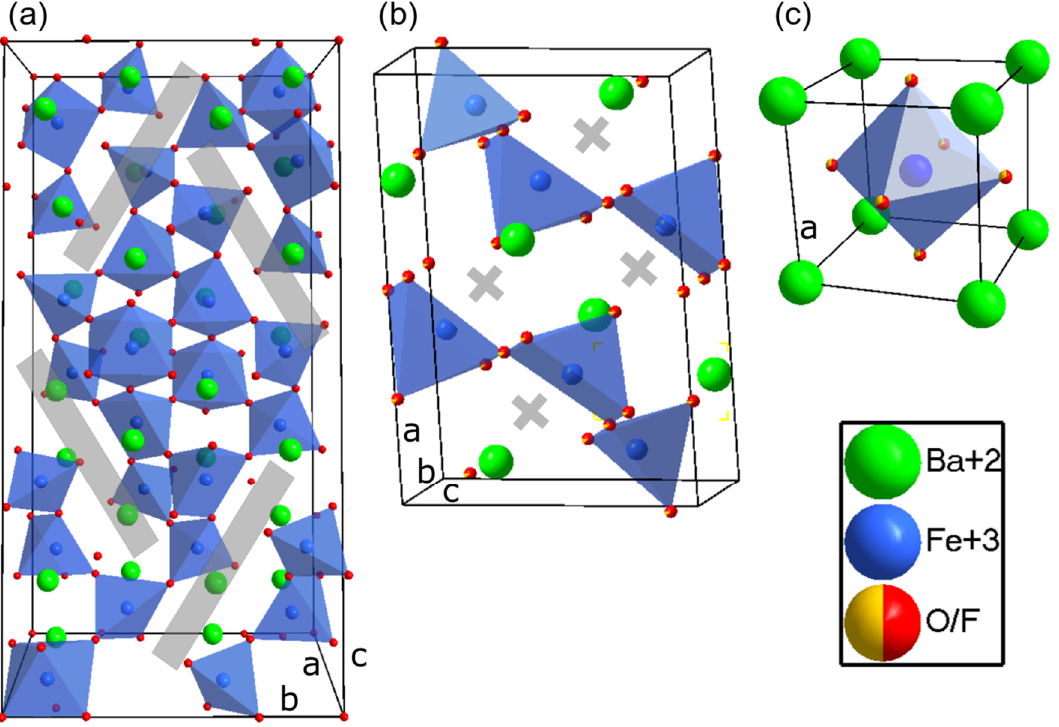
Figure 1. Defect structure of ( a ) BaFeO 2.5 ( P 2 1 /c ) and ( b ) BaFeO 2.67 /BaFeO 2.33 F 0.33 ( P 2 1 / m ) with bars/crosses indicating oxygen vacancy channels/relaxations [18,19], ( c ) depicts a defect free structure of BaFeO 2 F ( Pm 3 m ). Though BaFeO 2.67 is confirmed to have the same overall anion content BaFeX 2.67 than BaFeO 2.33 F 0.33 , neutron diffraction studies are yet needed to confirm the identical vacancy ordering pattern within the √ 6 × √ 2 × √ 3 monoclinic superstructure of the cubic perovskite modification.